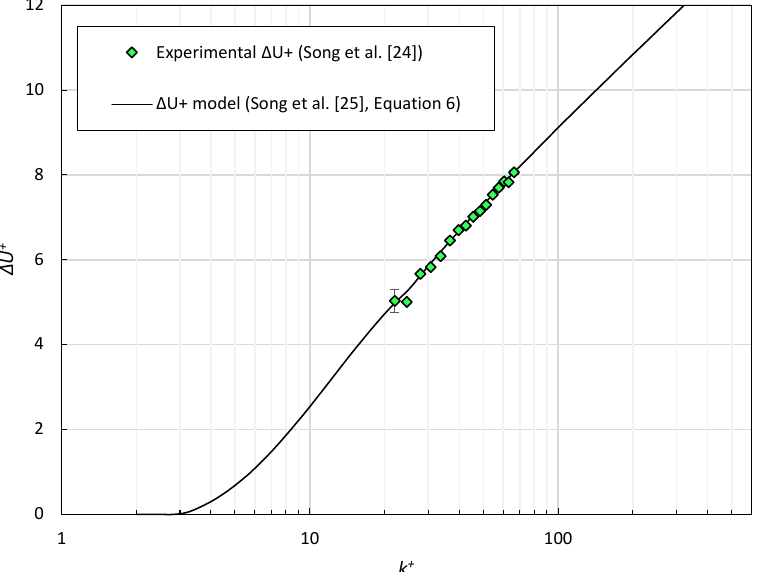
Figure 2. Experimental roughness function of Song et al. [24] and the roughness function model of Song et al. [25] Equation (6).